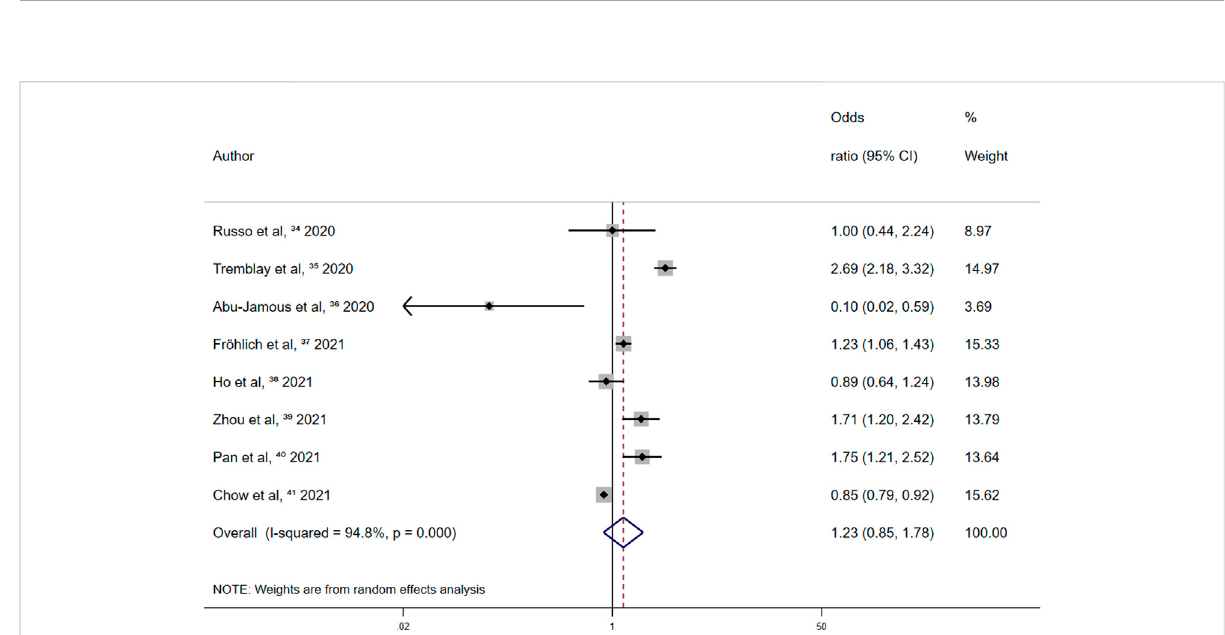
FIGURE 5 Summary odds ratio of all-cause mortality for other antiplatelet drugs use in retrospective